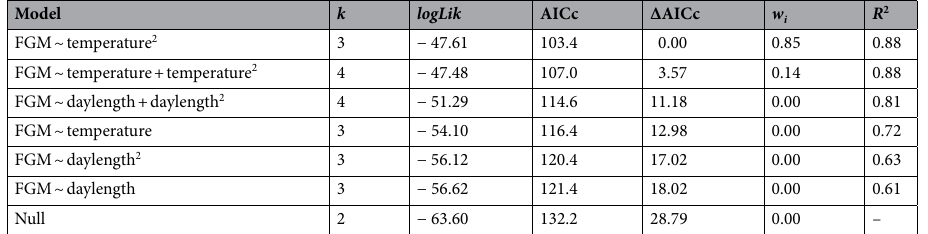
Table 1. Model selection summary of six candidate regression models. The fecal glucocorticoid metabolite (FGM) concentration of wintering whooper swans was used as the dependent variable, while day length, mean air temperature as well as their quadratic terms were used as independent variables. Models were ranked by Akaike Information Criterion values corrected for small sample size (AICc) and weights ( w i ), whereby higher weighted models received more support. K number of parameters included in the model, R 2 regression coefficient.